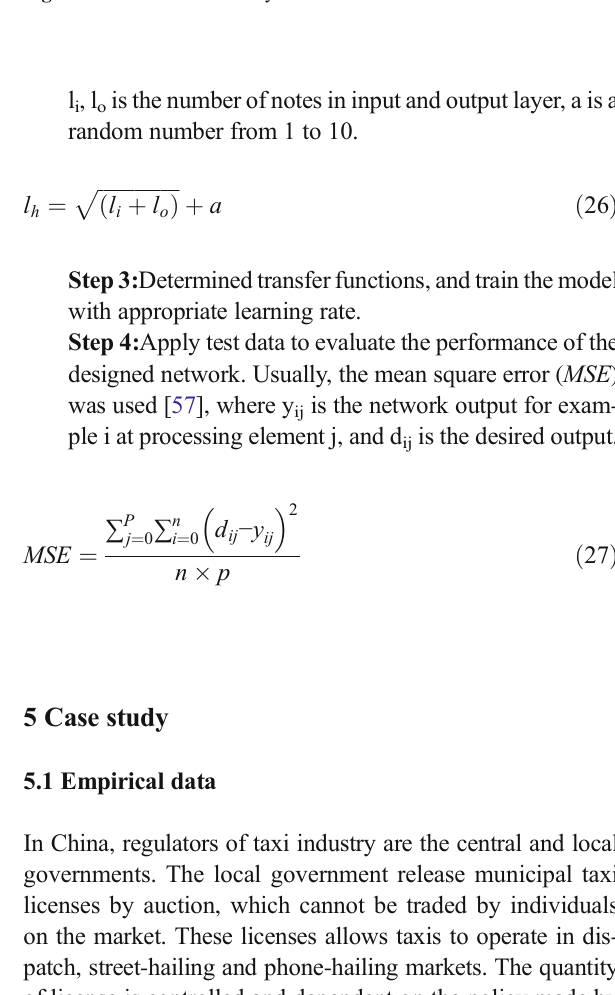
Fig. 5 Structure of a three-layer BP neural